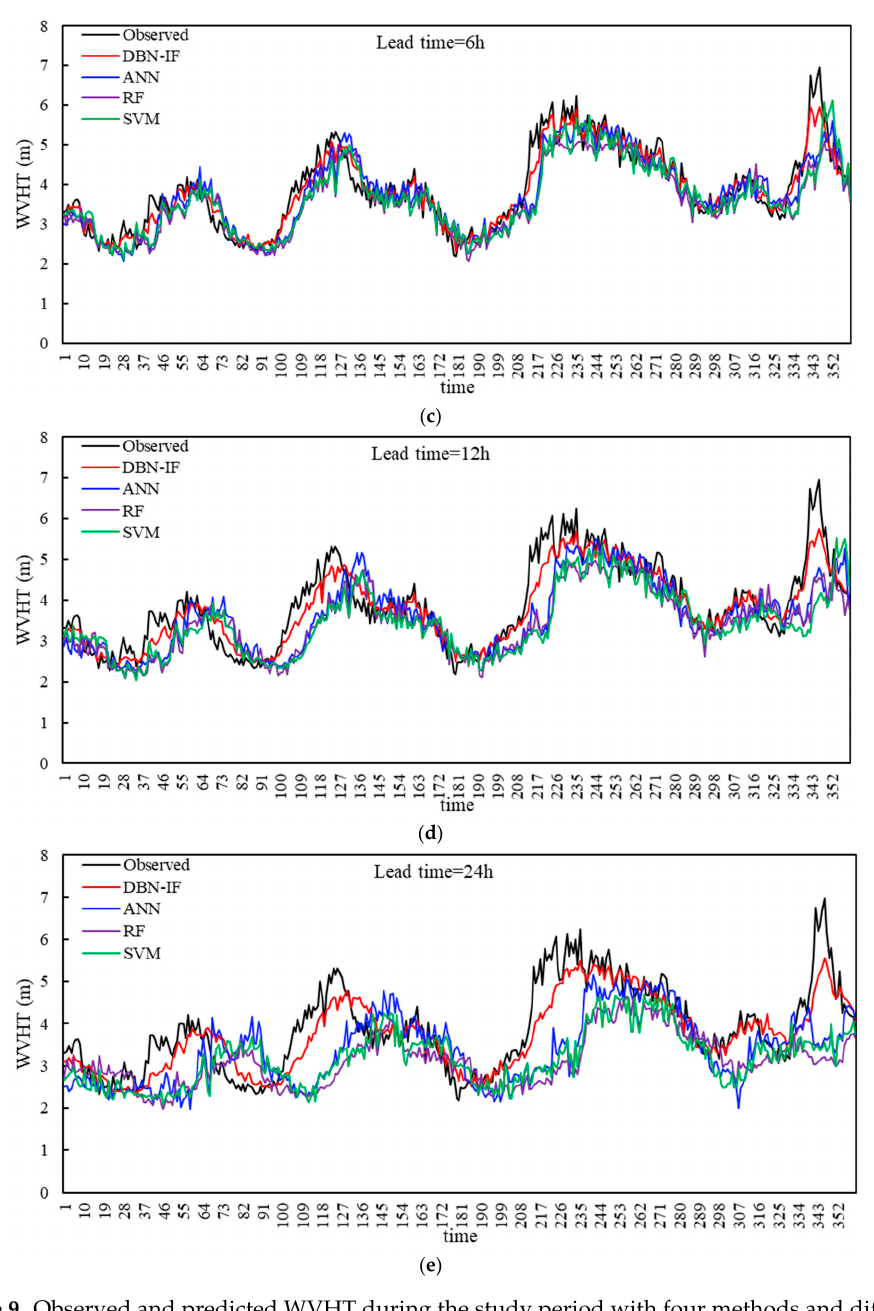
Figure 9. Observed and predicted WVHT during the study period with four methods and different lead times: ( a ) 1 h, ( b ) 3 h, ( c ) 6 h, ( d ) 12 h, ( e ) 24 h. lead times: ( a ) 1 h, ( b ) 3 h, ( c ) 6 h, ( d ) 12 h, ( e ) 24